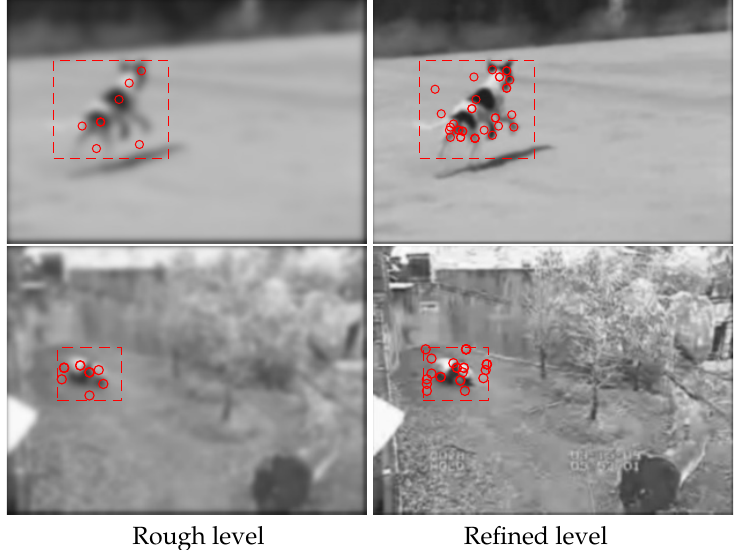
Figure 3. Multi-level features points of reference images, where features are described as a red circle, and a detected object is surrounded by a rectangle. In the first column, the rough features are marked, and, in the second one, refined